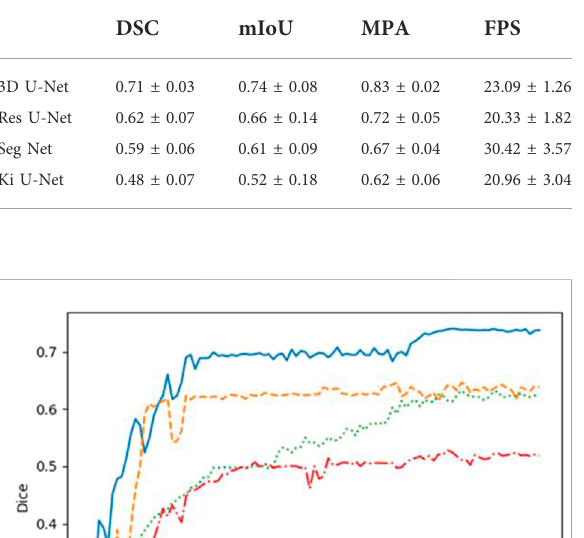
TABLE 5 Comparison of experimental results of different algorithms on the test set.